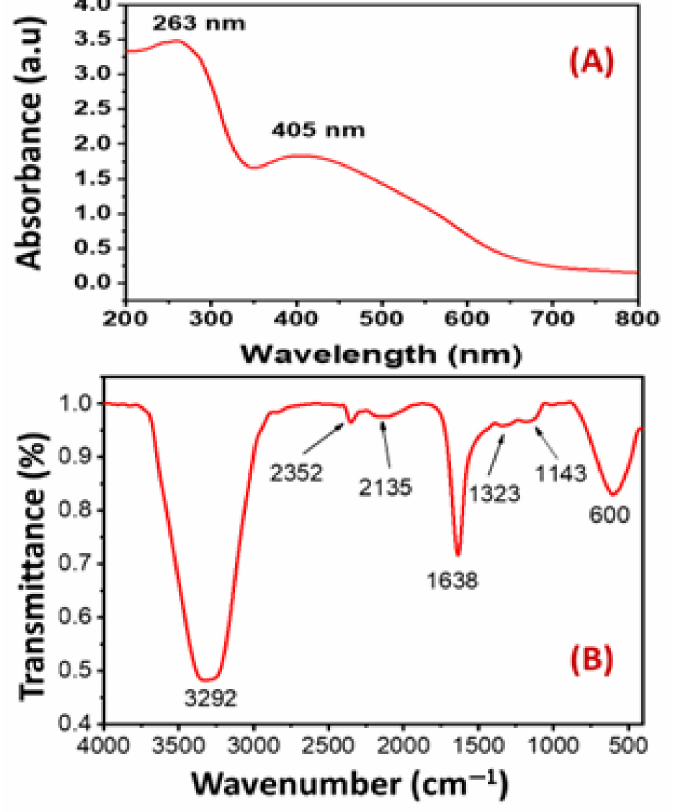
Figure 2. ( A ) is the UV/Vis spectrum and ( B ) is the FTIR spectrum of bio-waste Ag-based